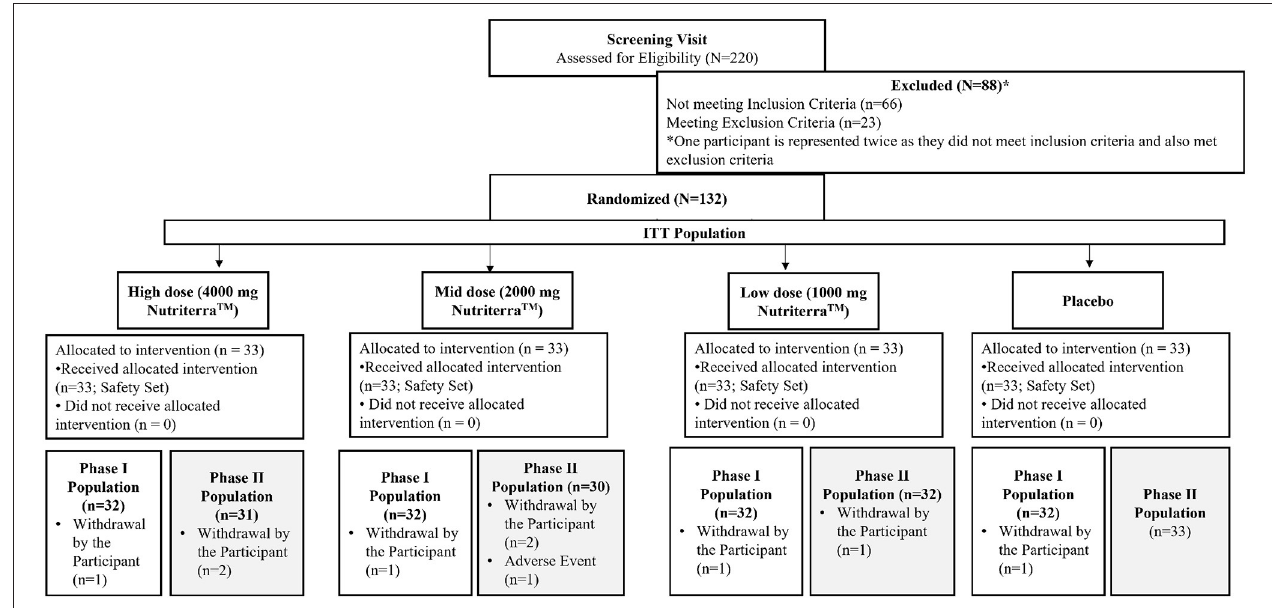
FIGURE 1 | CONSORT diagram for participant disposition.